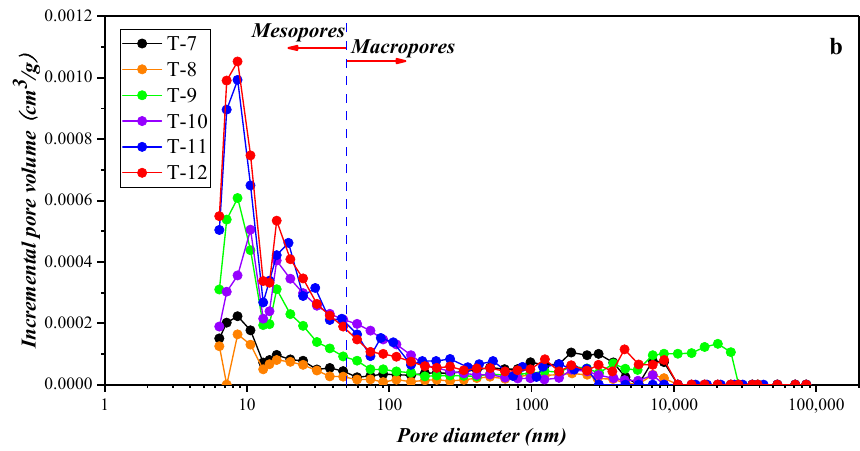
Figure 6. Pore size distribution by the high-pressure mercury injection experiment for the 12 shale samples: ( a ) The first six shale samples, ( b ) The last six shale samples.